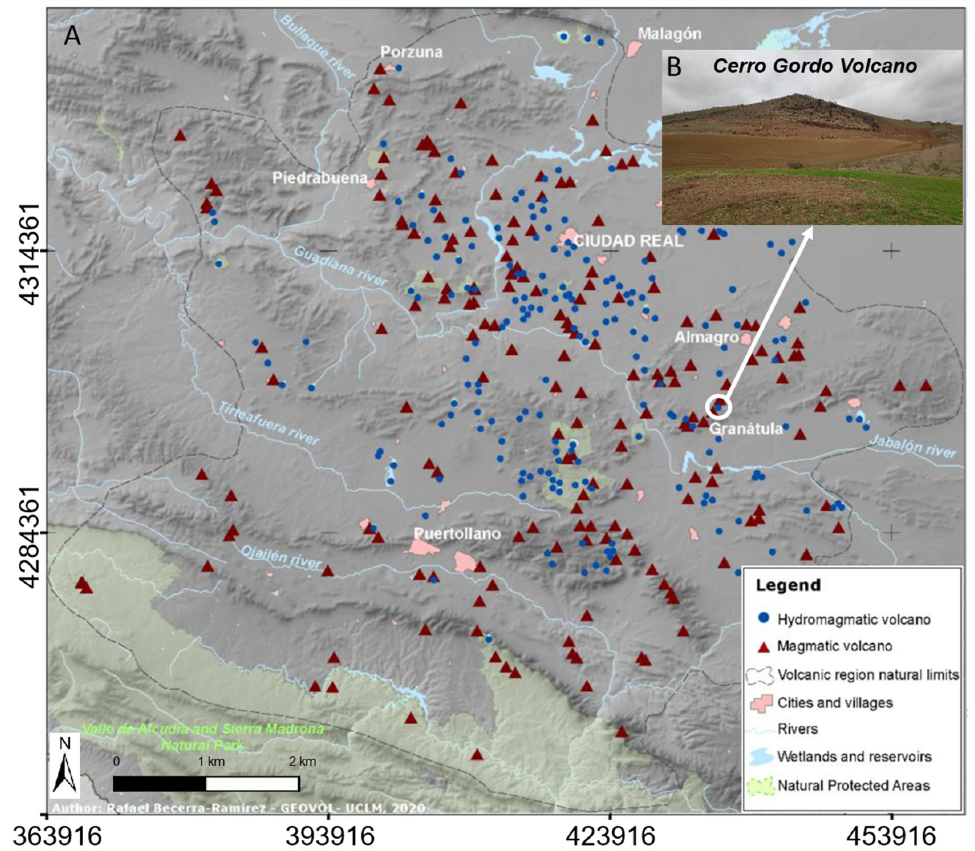
Figure 11. ( A ) Map of the volcanoes of Campo de Calatrava from Rafael Becerra-Ramírez el al. 2020 [83] indicating the position of the Cerro Gordo volcano. ( B ) Photograph of the Cerro Gordo volcano.